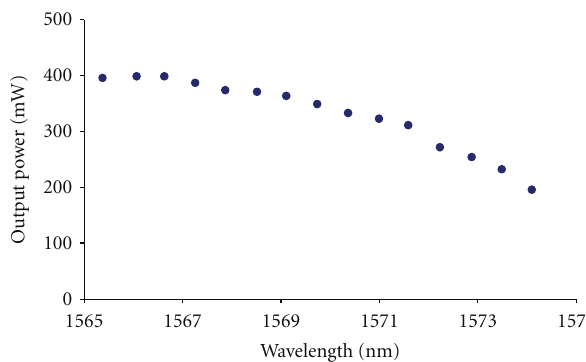
Figure 3: Output power of the laser at ∼ 0.6 nm intervals from 1565 nm to 1575 nm